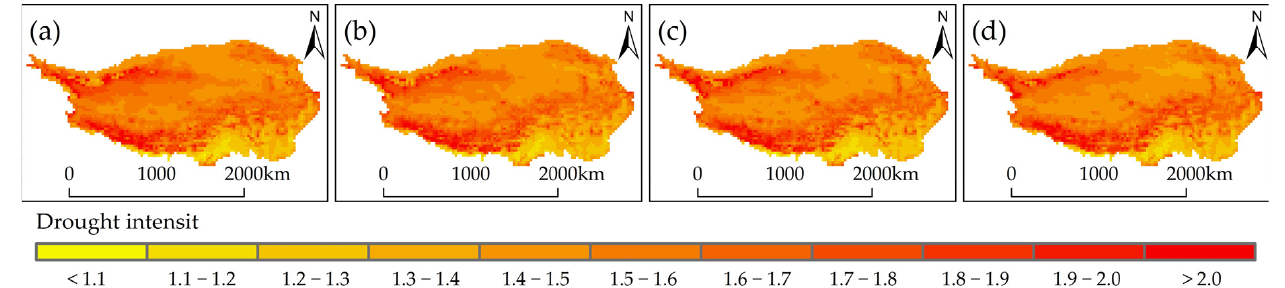
Figure 11. Spatial distribution characteristics of sub-mean drought intensity on the TP from 2016 to 2099 under the ( a ) RCP2.6, ( b ) RCP4.5, ( c ) RCP6.0, and ( d ) RCP8.5 climate scenarios.